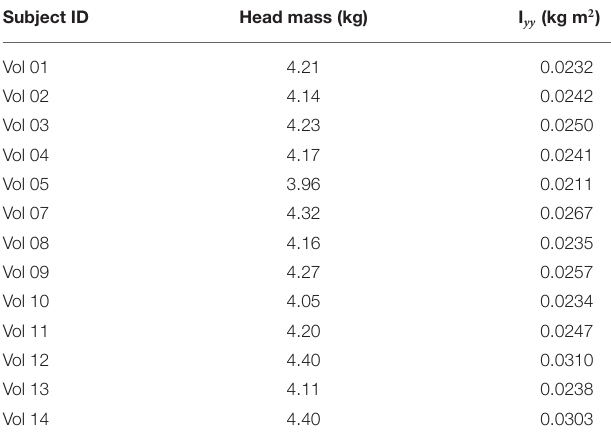
TABLE 4 | Calculated head inertial